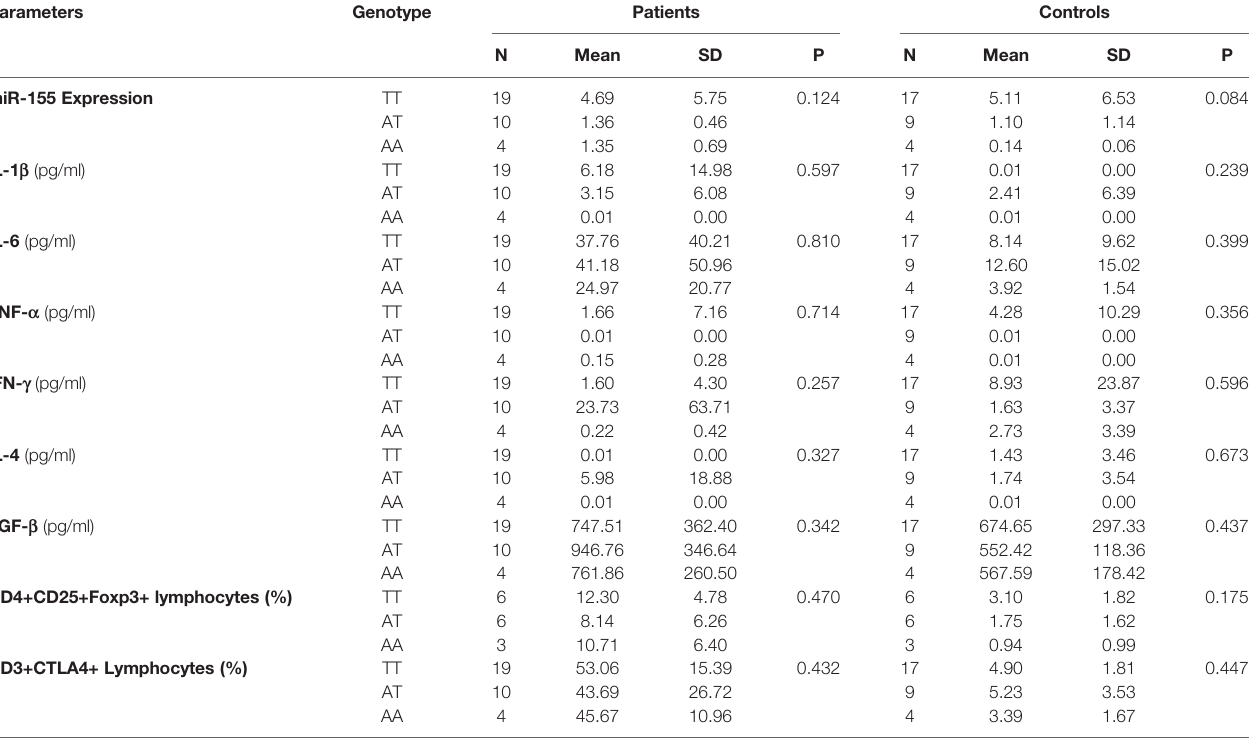
TABLE 8 | Effect of the Rs767649 genotypes on miR-155 expression, cytokines, and Treg, CD3+CTLA-4+ cells. Parameters